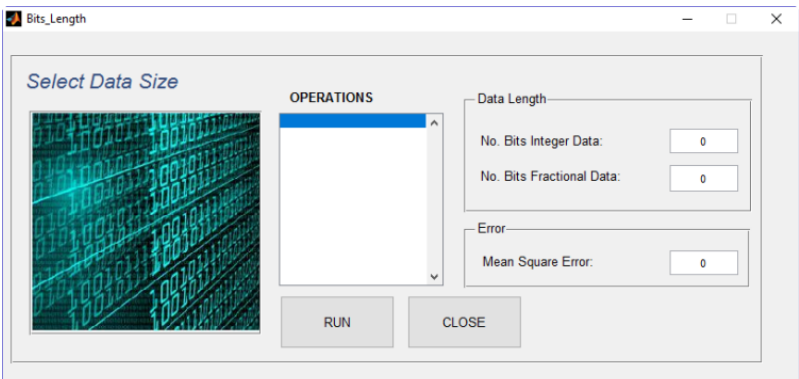
Figure 6. Bit length option in the software design